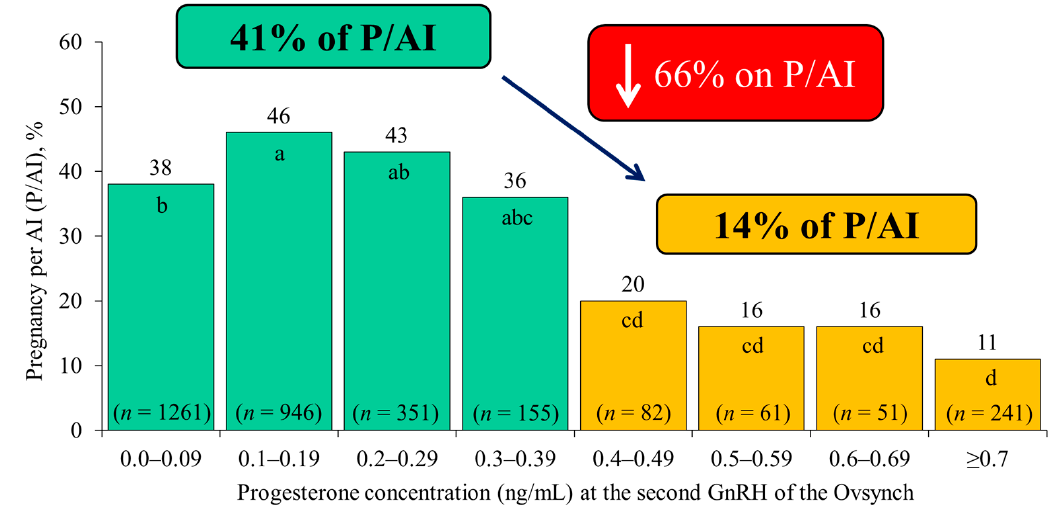
Figure 3. Pregnancy per AI (P/AI) in lactating dairy cows in relation to progesterone concentration at the time of the second gonadotropin releasing-hormone (GnRH) of the Ovsynch protocol. a,b,c,d Different letters represent differences ( p < 0.05). From [6].